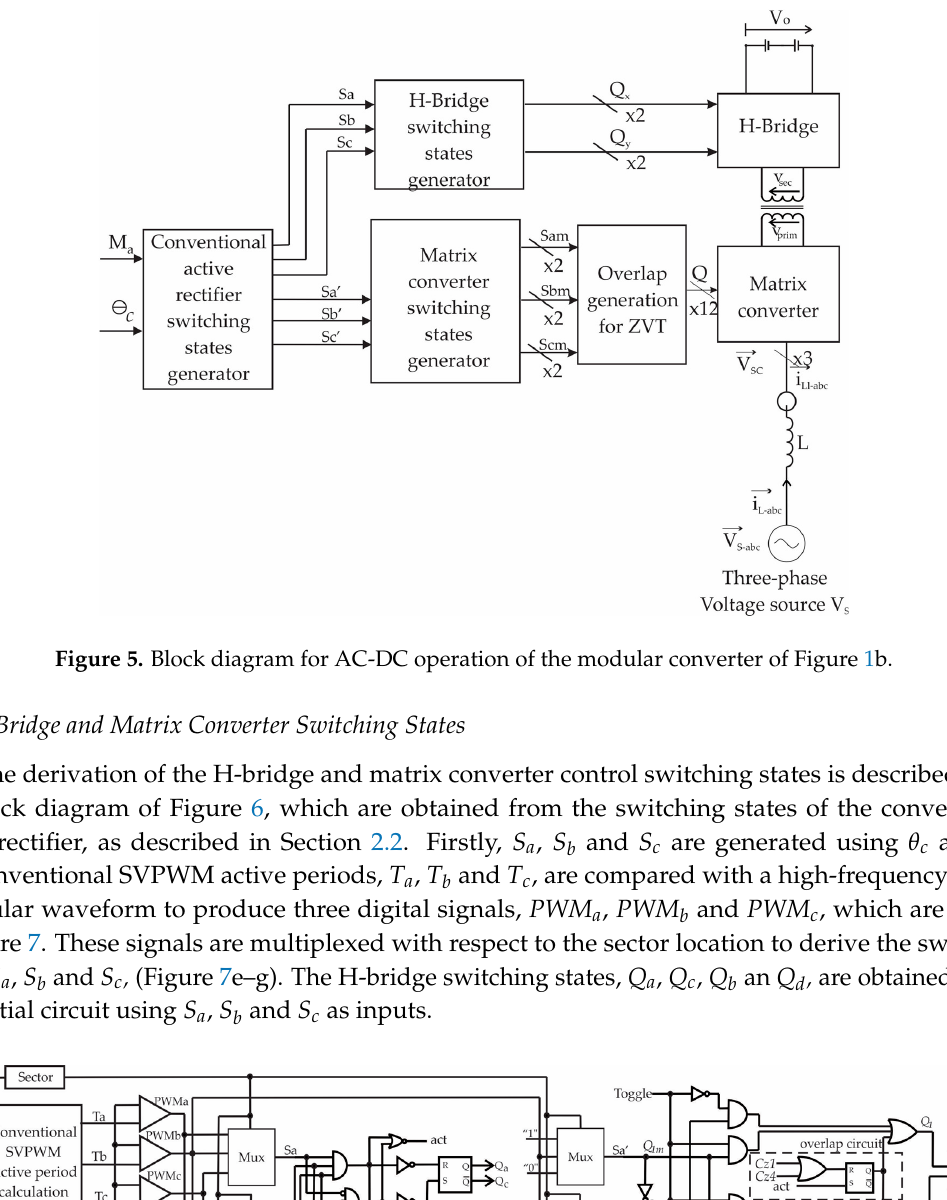
Figure 6. Block diagram to generate the switching states for the matrix converter and the H bridge.